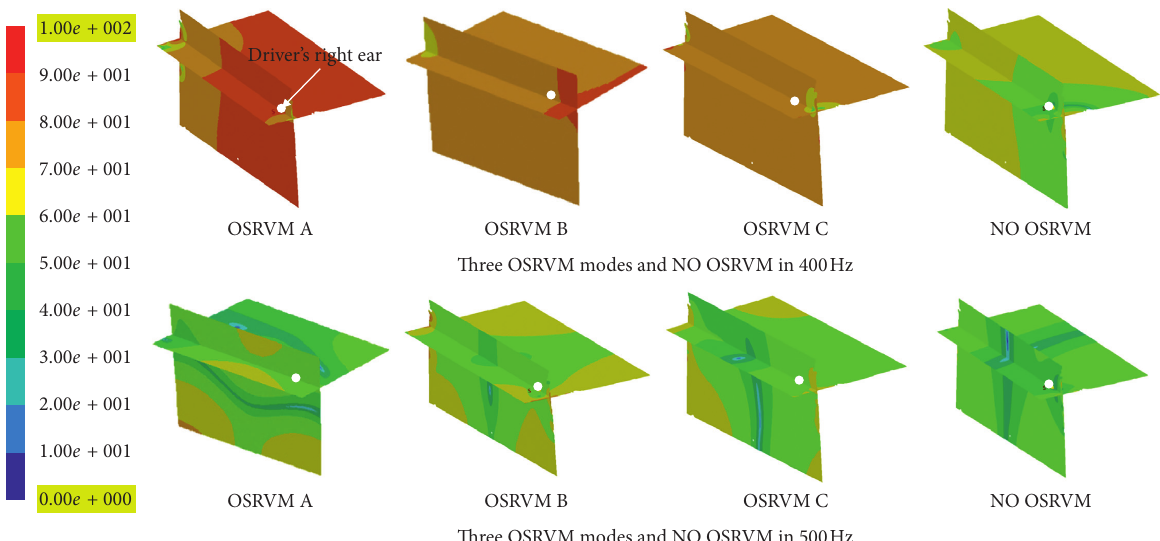
Figure 12: The distribution of the sound pressure level of four statuses at the field point in the cab.